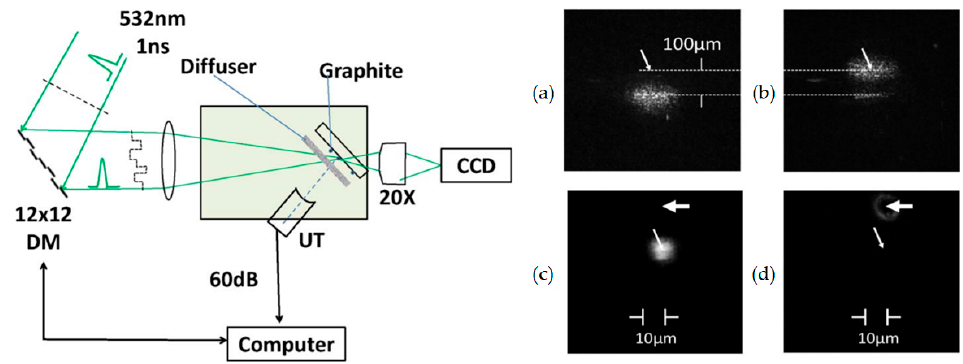
Figure 2. Left: experimental schematic of the first photoacoustically guided optical focusing system. DM, deformable mirror; UT, ultrasound transducer. Right: optical spot behind the scattering layer ( a ) before and ( b ) after being guided to the ultrasonic focal spot (marked by the arrows) via wavefront shaping; ( c ) a photo of graphite particle (marked by wide arrow) after being shifted to 10 µm from the optical beam; and ( d ) the refocused optical beam centered at the graphite particle after wavefront shaping. The narrow arrows mark the locations of the center of ultrasonic focus. The diameter of the ultrasound focus is 90 µm (Figure from ref. [25]).